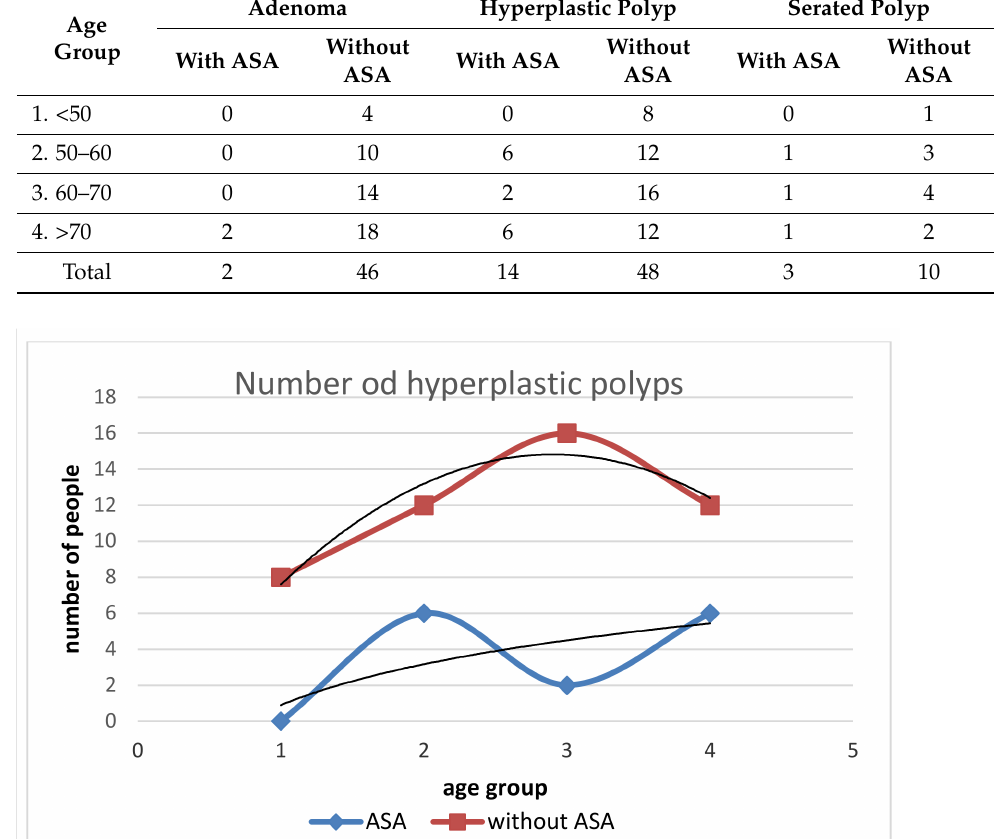
Table 2. Occurrence of polyps in age groups for the with ASA and without ASA groups.